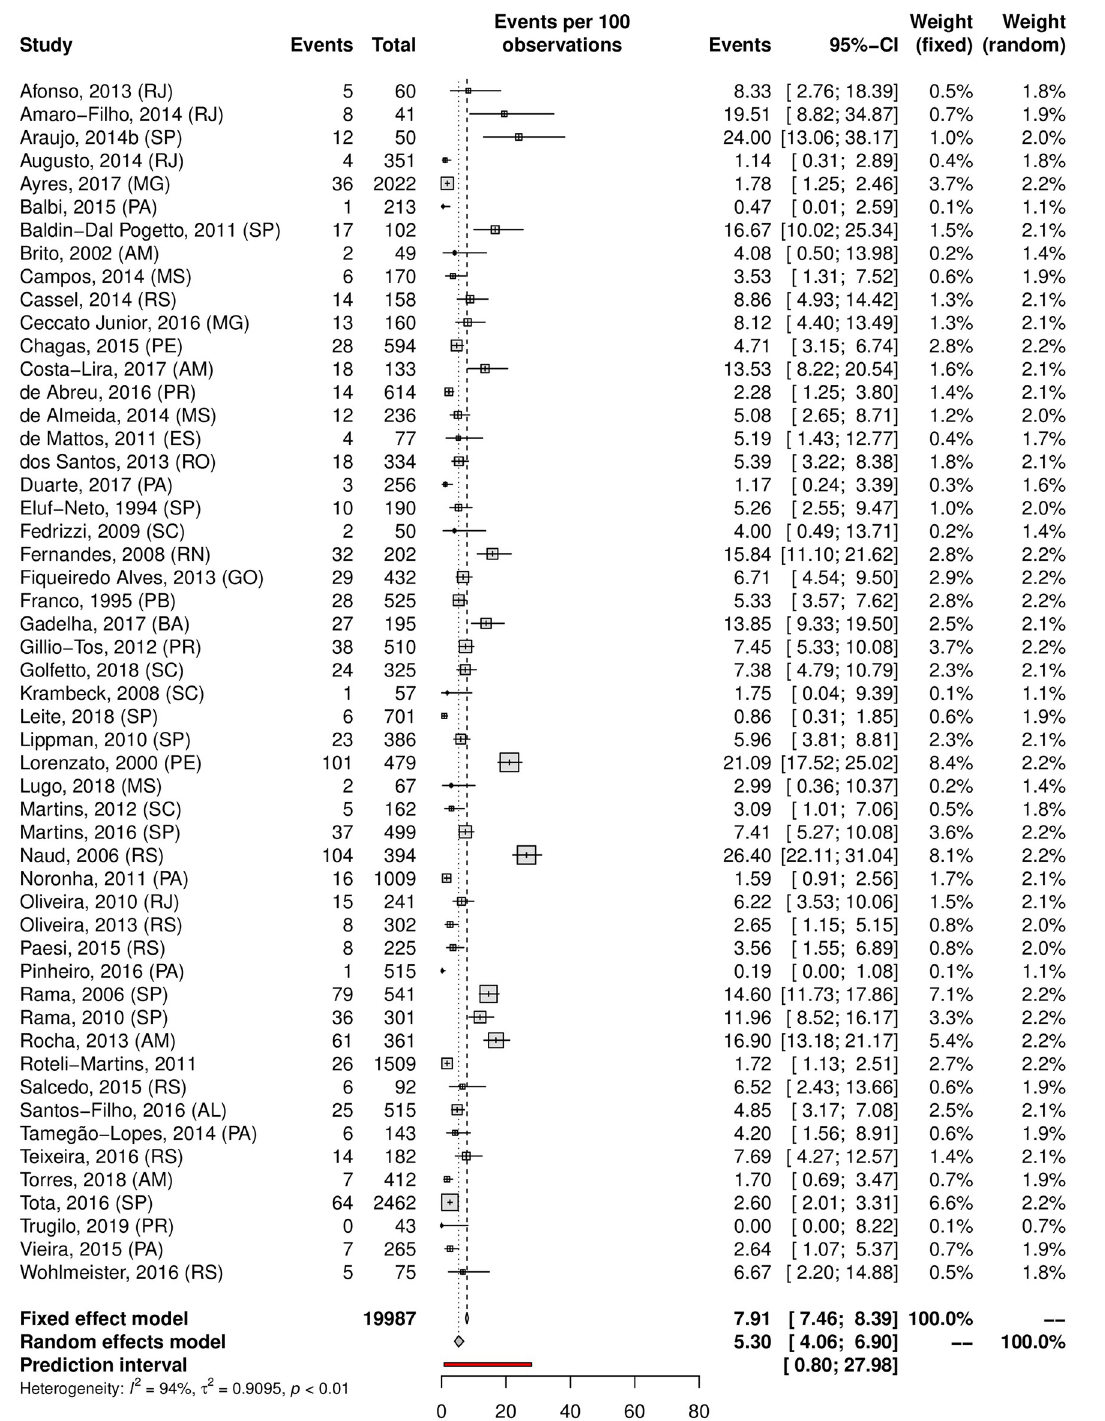
Fig 3. Overall prevalence of cervical infection by HPV-16. Forest plot of a metanalysis of studies reporting prevalence of cervical infection by HPV-16 in Brazil.